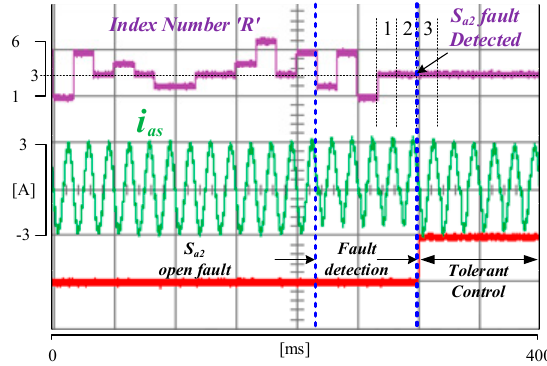
Figure 13. Experimental result for open-switch fault diagnosis algorithm.